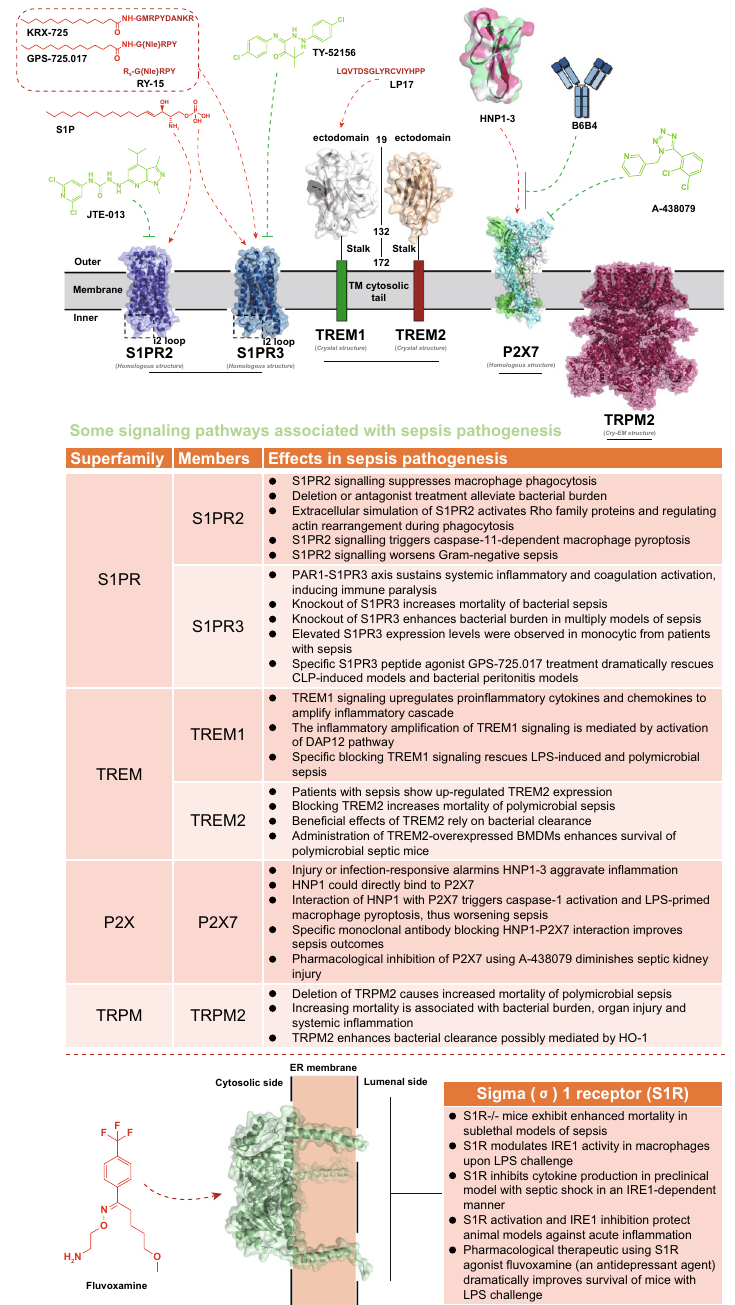
Fig. 2 Brief summary of some novel molecular pathways and their potential therapeutic